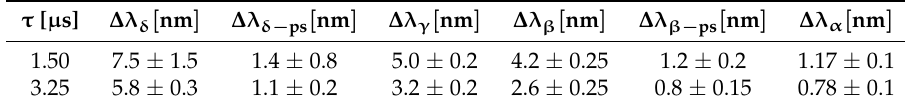
Table 1. First four Balmer-series FWHM and H δ and H β peak separations from line-of-sight data at